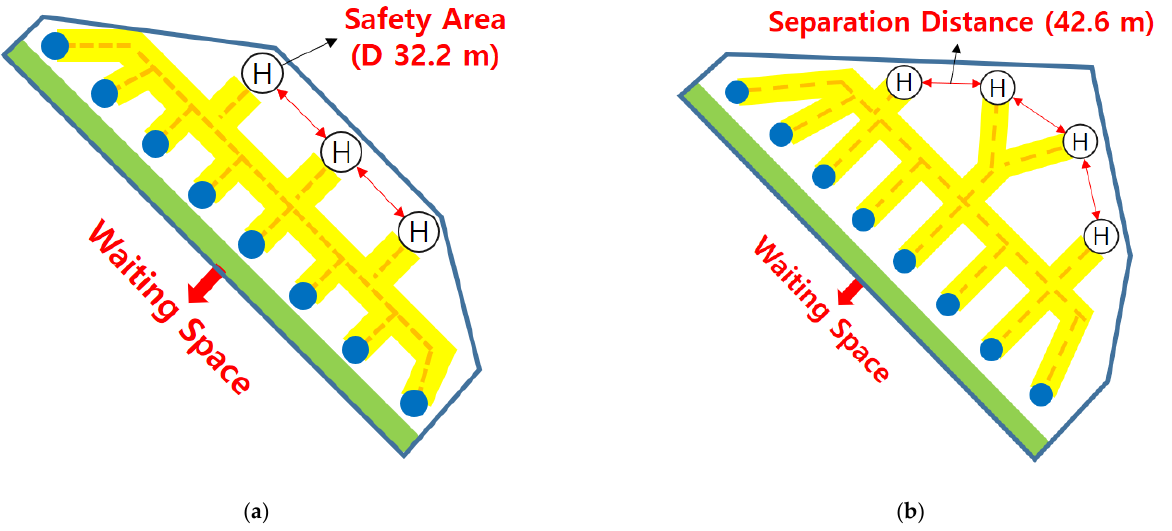
Figure 18. Linear topologies for the Gimpo Airport parking lot that comply with the EASA’s new regulations: ( a ) current parking space; ( b ) expanded parking